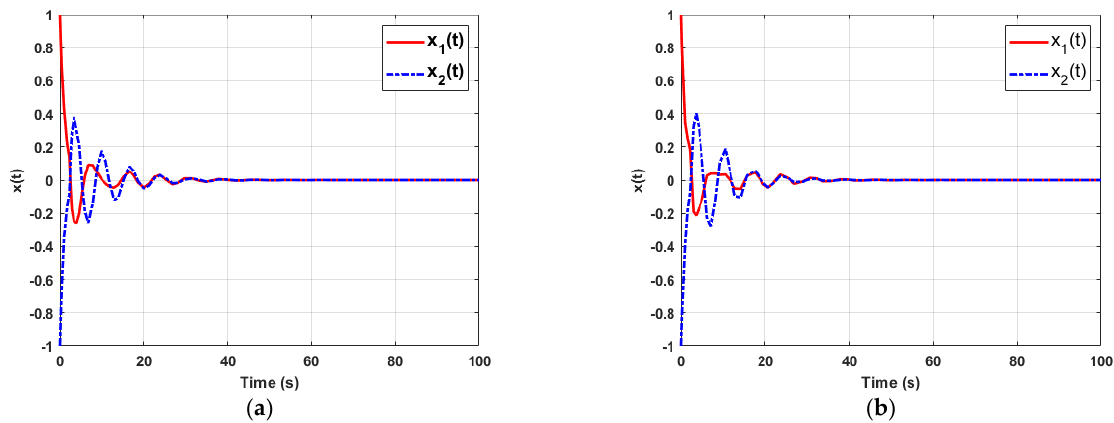
Figure 1. State trajectory of the system for Example 1: ( a ) State trajectory of the system for Example 1 with τ = 0.1, h = 2.2963 ; ( b ) State trajectory of the system for Example 1 with τ = 1, h = 2.3775 .